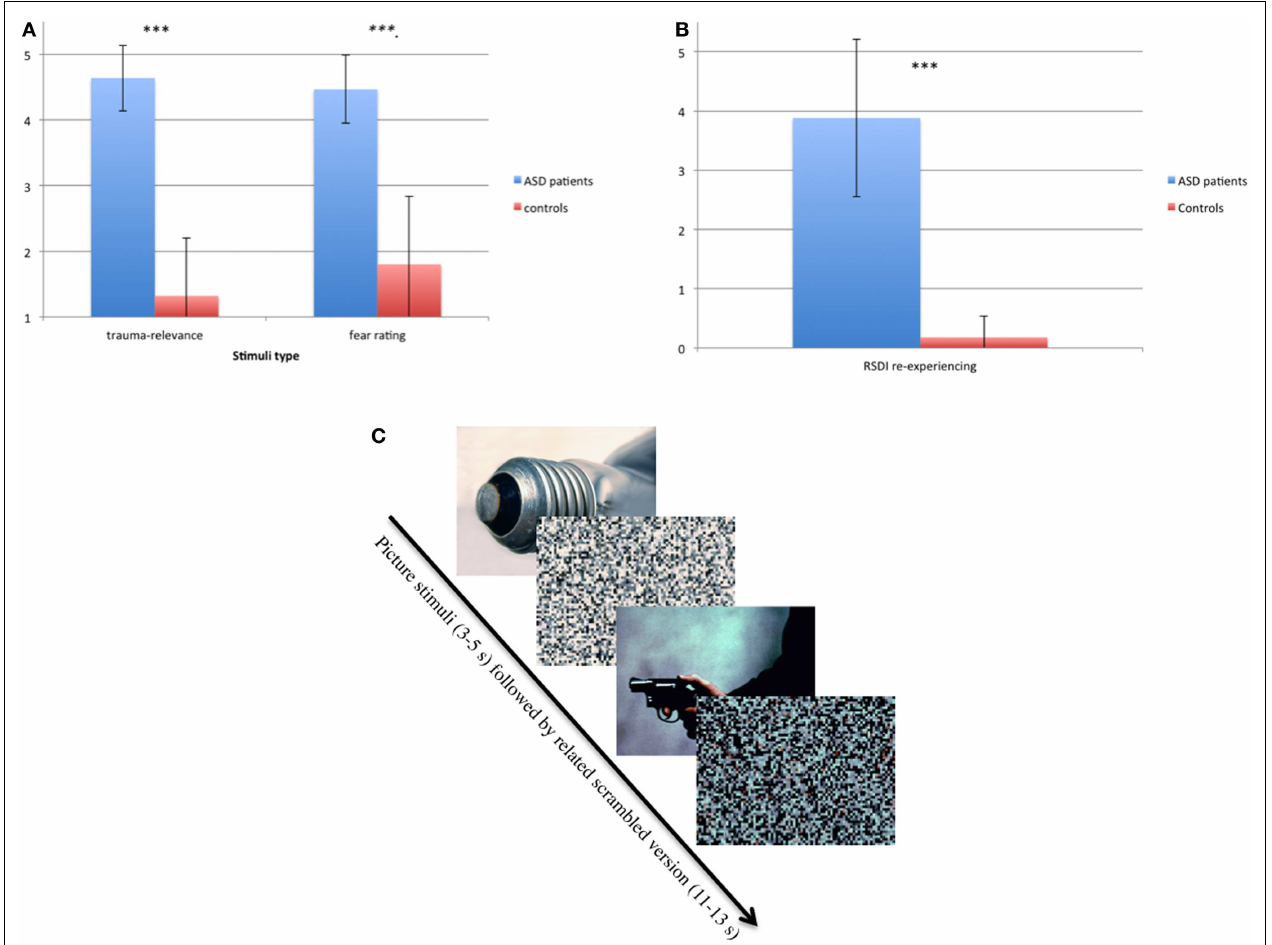
participants immediately after the symptom provocation procedure in the scanner. *** p < 0.001. (C) Example of the two types of pictures (neutral and trauma-related) taken from IAPS (36) and their scrambled version.